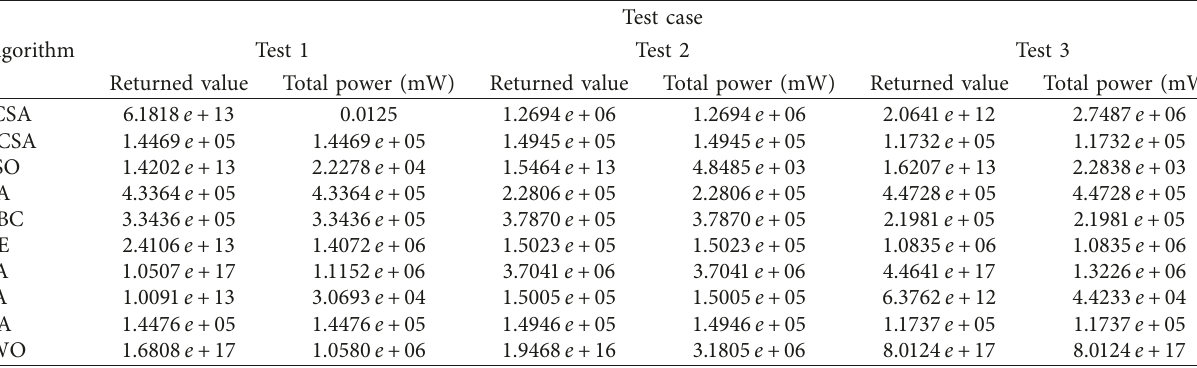
Table 17: Returned values and total power of ACSA and other standard optimization algorithms in scenario 2 in three more test cases. Algorithm